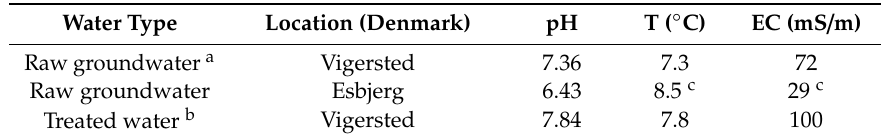
Table 2. Three groundwater types used in the method development and validation (preservation and SPE). Water parameters presented are measured in the